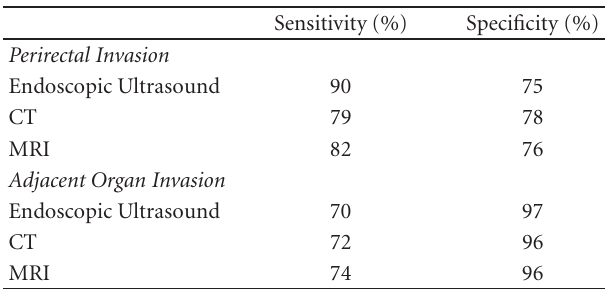
Table 1: Sensitivity and specificity of endoscopic ultrasound, CT, and MRI for perirectal and adjacent organ invasion